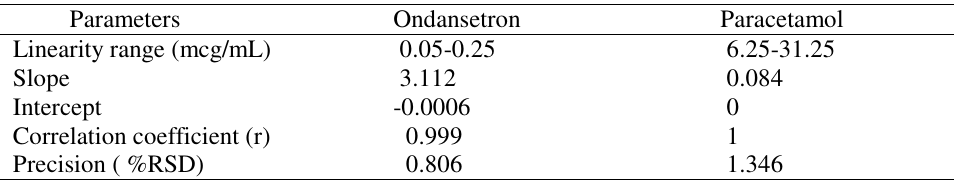
Table 2. Validation